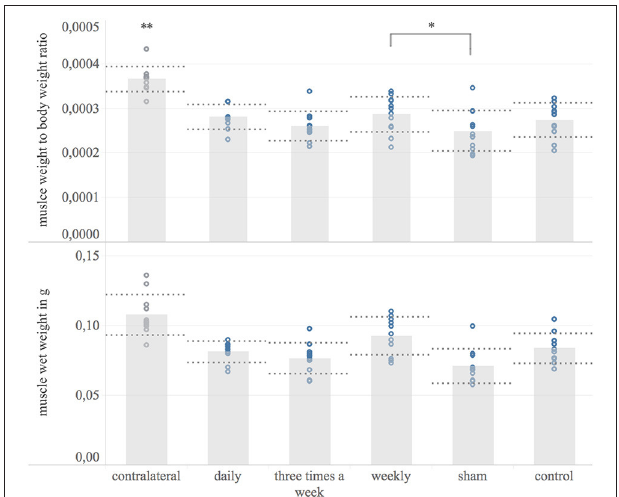
FIGURE 6 | Target muscle wet weight. Shown are bar graphs of the mean muscle wet weight to body weight ratio (Upper) and the mean wet weights of the ipsilateral flexor digitorum superficialis muscle in microgram [ µ g] (Lower) with standard deviation (dashed lines) combined with scatter plots of the measured data (dots) 8 weeks post-surgery. *The weekly treated group showed significantly higher muscle weight to body weight ratio compared to the sham-group. **The contralateral muscle weight normalized to body weight was significantly higher compared to the operated side among all experimental groups.